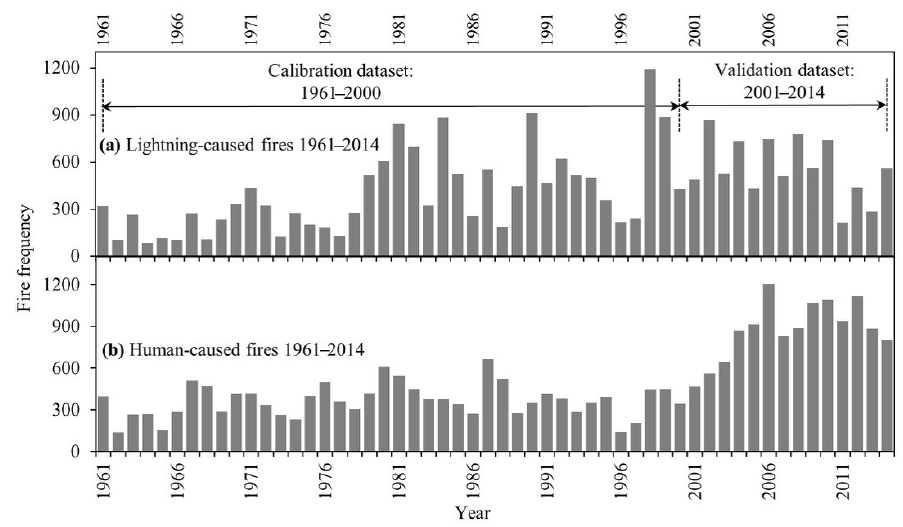
Figure 2. Frequency distribution of the ( a ) lightning- and ( b ) human-caused fire occurrences in 17 natural subregions of Alberta from 1961–2014.